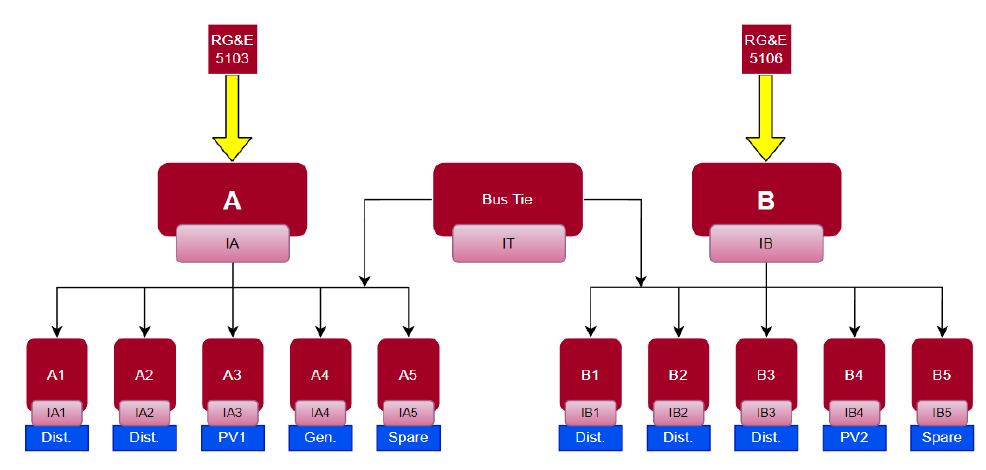
Figure 22. Top-level view of the university campus distribution